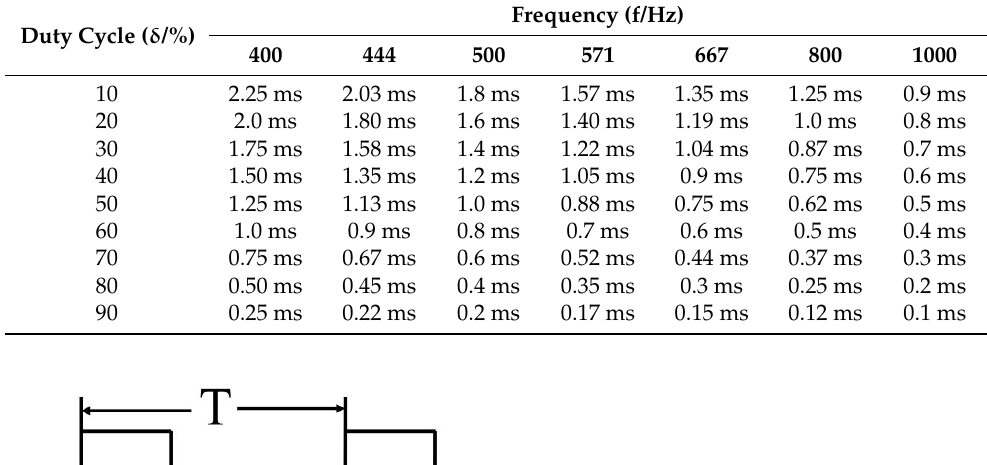
Table 2. Cooling time (ms) for frequency (Hz) and duty cycle (%).